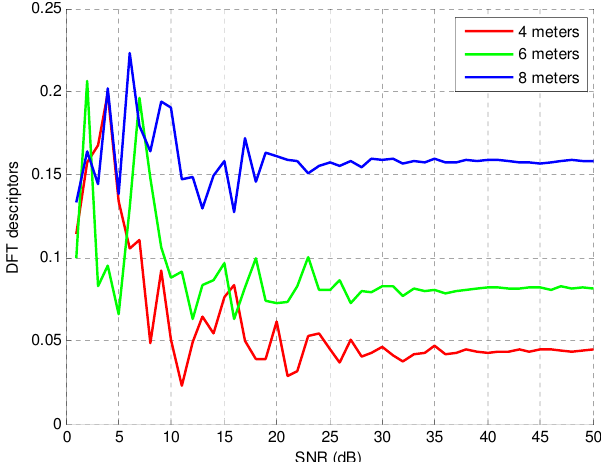
Figure 4. Impact of additive white Gaussian noise on the DFT descriptor.